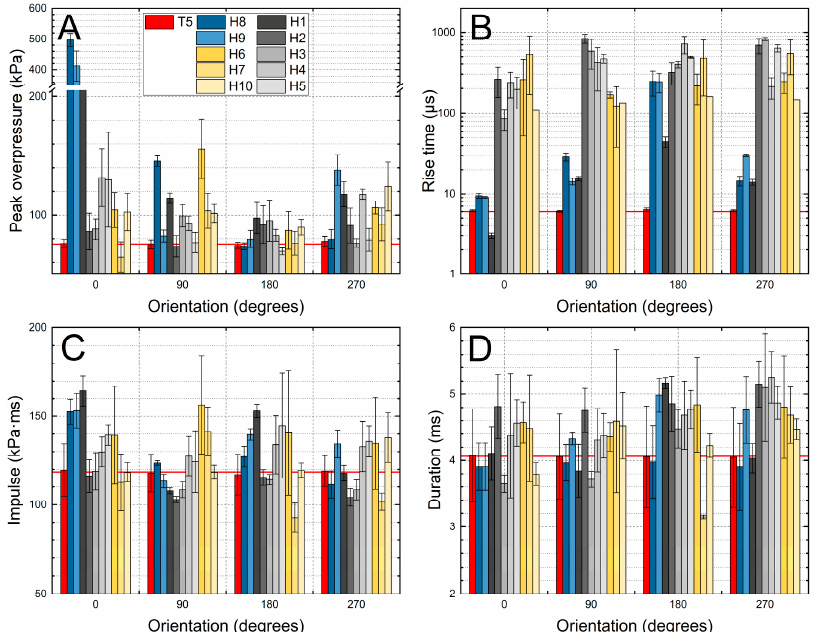
Figure 3. The effect of the orientation on pressure distribution under the helmet. The results of the quantification of the four characteristics of the pressure waveforms: ( A ) peak overpressure, ( B ) rise time, ( C ) impulse, and ( D ) duration are presented. The data collected at 70 kPa incident blast overpressure (BOP) (~10 psi, denoted as T5) are expressed as average ± standard deviation. The red horizontal lines behind the data indicate average incident shock wave characteristics and are plotted as a reference to visualize the trends in the data.